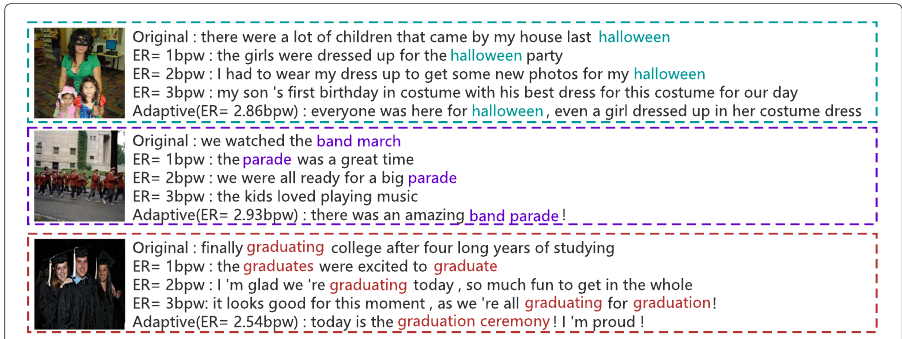
Fig. 3 Some examples of steganographic visual stories generated from single photo under different embedding rates. Colored words represent the core words to express the content of